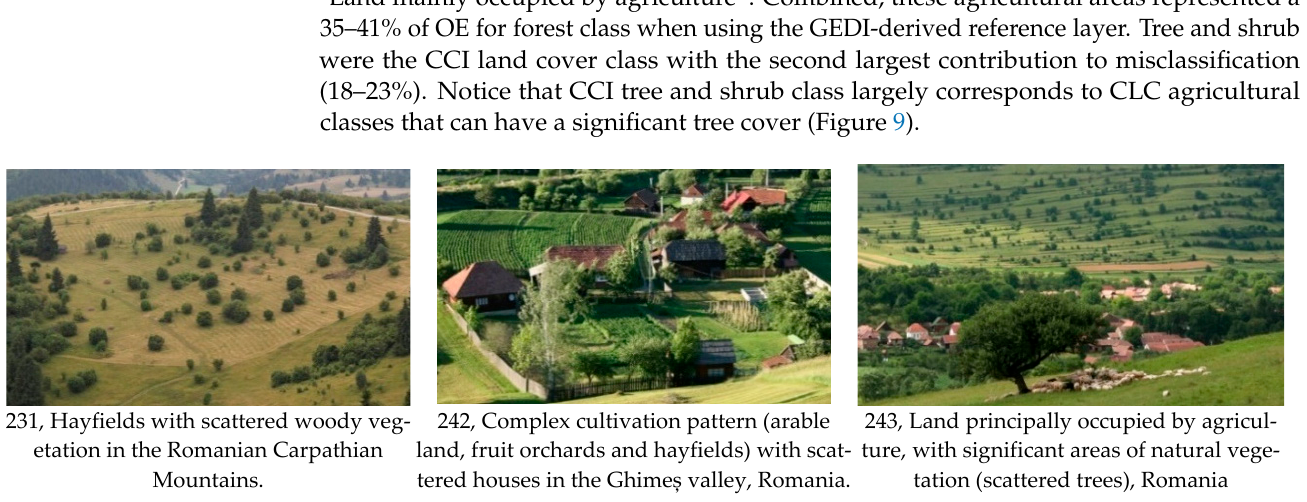
Table 6. Tropical site errors (%) disaggregated by land cover (Ur, Urban; LV, low vegetation; Fo, forest; ence, and BCC—further adding short-term coherence statistics. Complete matrices in Appendix A (Table A3). Cells are shaded with a green-yellow gradient, indicating lower and higher